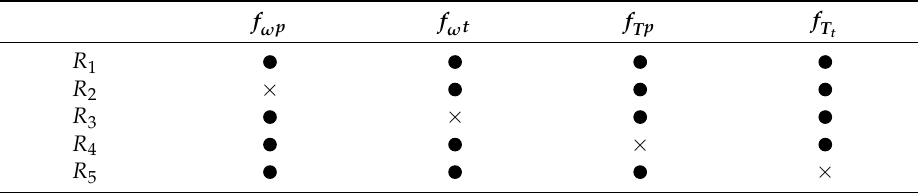
Table 8. Summary of the testing results of the five